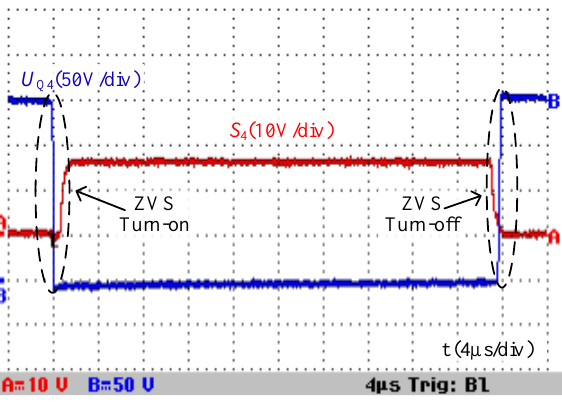
Figure 18. Gate signal and voltage stress of synchronous rectification power semiconductor Q 1 .